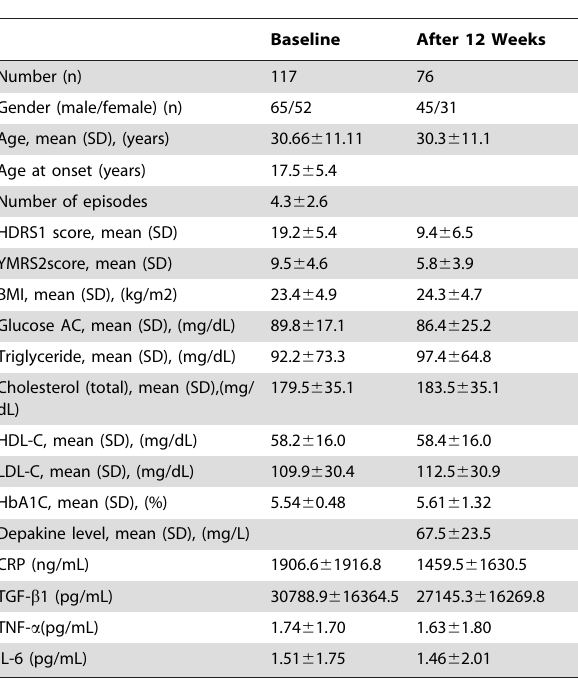
Table 1. Mean HDRS score, YMRS score, and cytokine and metabolic profiles before and after pharmacological